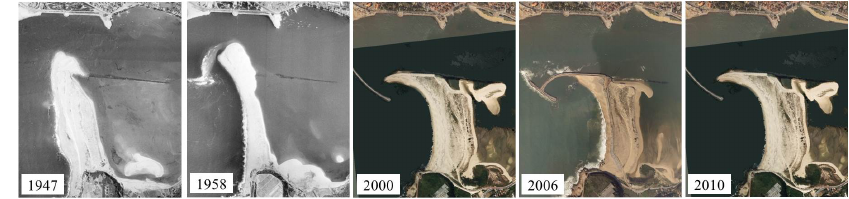
Figure 6. Orthoimages of the sandspit in five different periods (images provided by aerial national mapping agency aerial photography